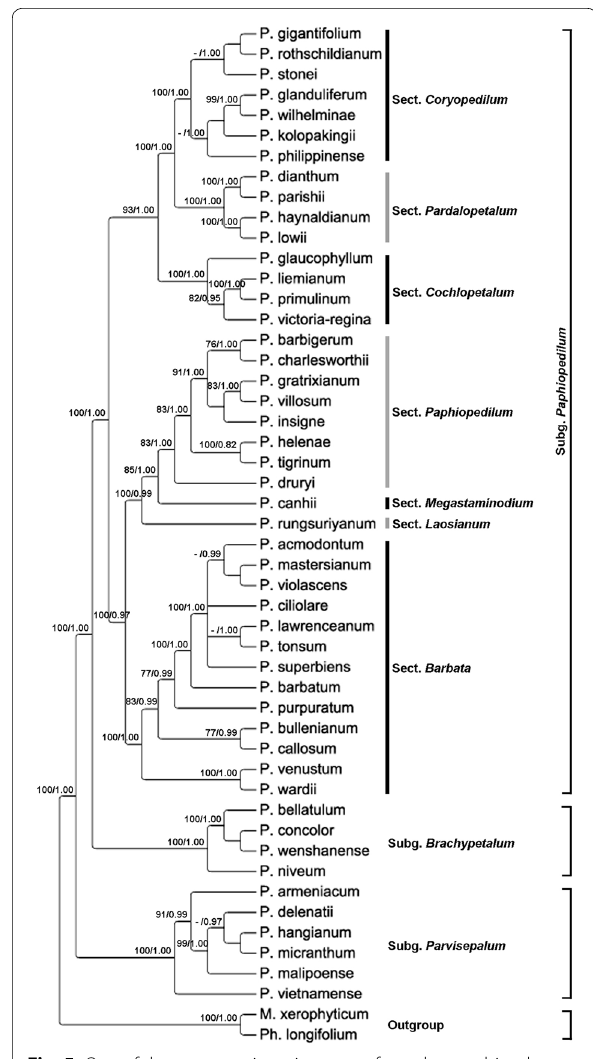
Fig. 5 One of the most parsimonious trees from the combined analysis of ITS, three low‑copy nuclear genes ( ACO , DEF 4 and RAD 51) and four plastid regions ( atp I‑ atp H, matK , trn S‑ trn fM and ycf 1) for Paphiopedilum . Bootstrap percentages (BP) >70 and Bayesian posterior probabilities (PP) are given for supported clades above the